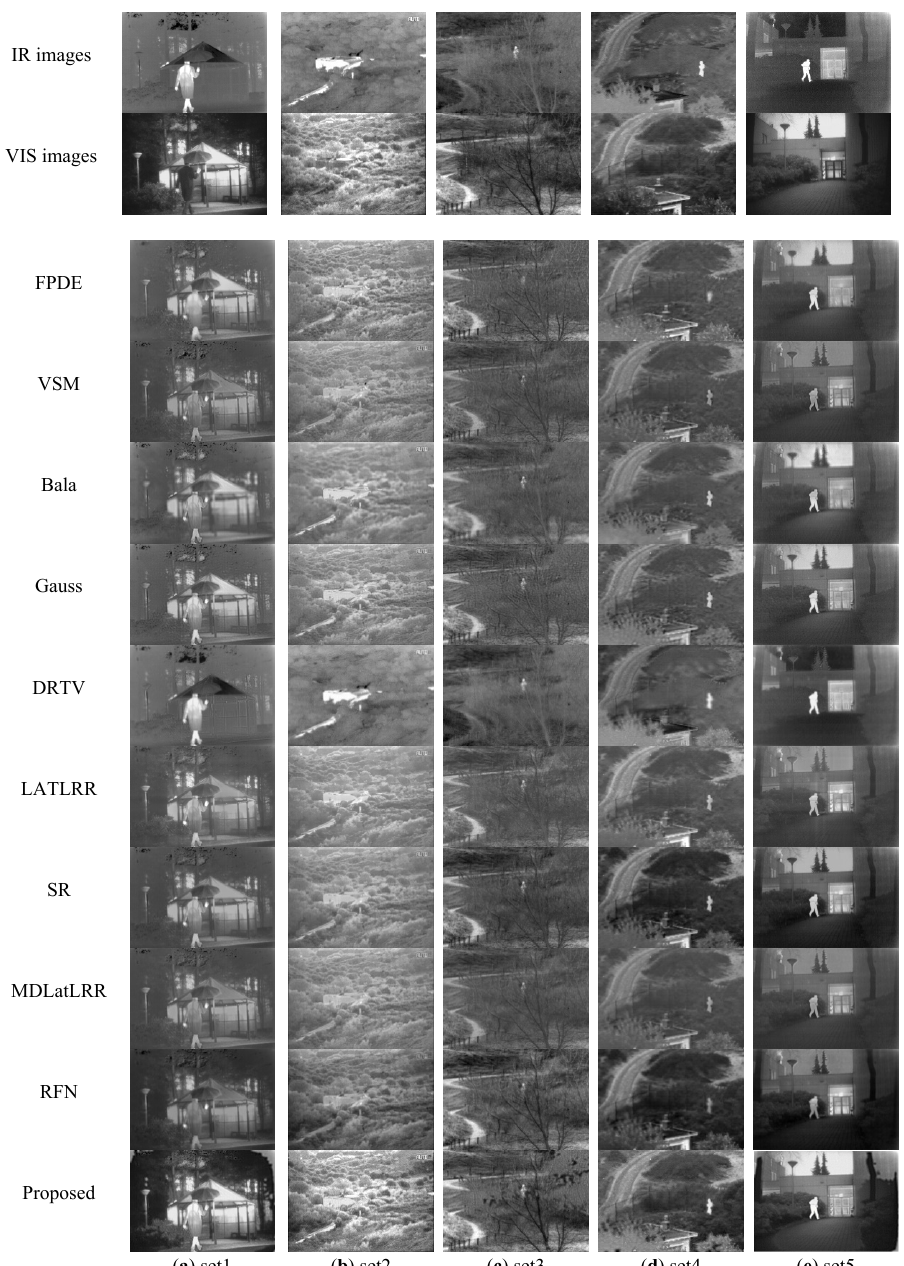
Figure 5. Results on TNO dataset. From the first row to the last row are IR images, VIS images, the fusion results of FPDE, VSM, Bala, Gauss, DRTV, LATLRR, SR, MDLatLRR, RFN, and the proposed methods.